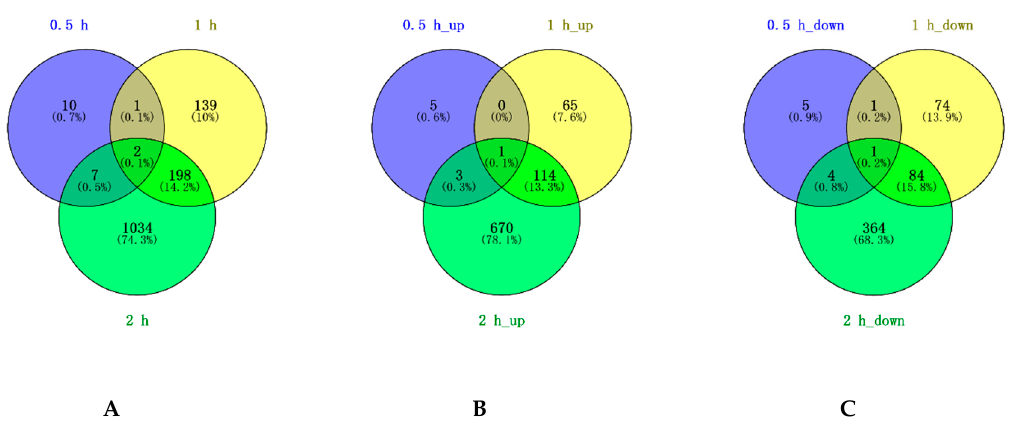
Figure 2. Venn diagram of differentially expressed genes (DEGs) under 0.5, 1 and 2 h of PEG stress in P3-198. ( A ), ( B ), and ( C ) show the Venn diagram results for the total, up-regulated, down-regulated genes, respectively.